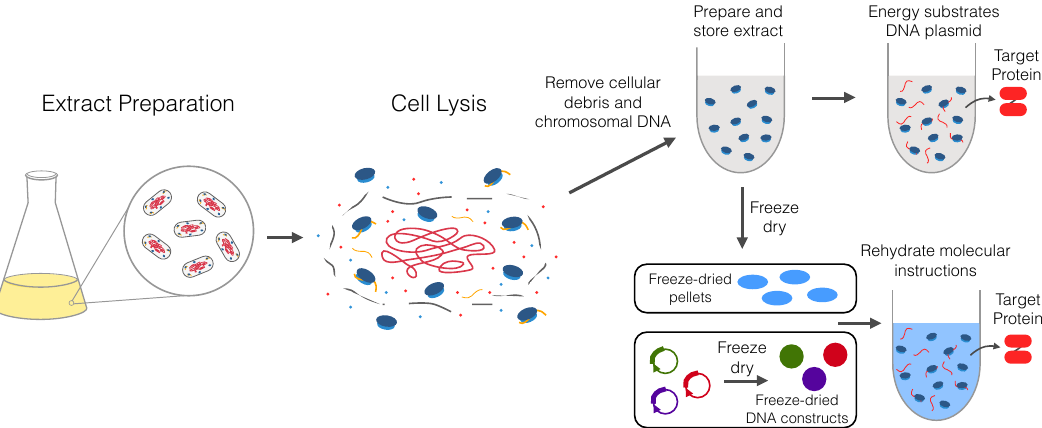
Figure 2. Schematic of cell-free protein synthesis. Cell extract is prepared by cell lysis, and cellular debris and chromosome DNA is removed. An energy source along with the necessary amino acids, nucleotides, and cofactor are added to the cell-free reaction. Template DNA of the target protein is added. The target protein is then easily purified from the cell-free system. Alternatively, cell-free extract can be freeze dried into pellets and paired with lyophilized DNA. Through the simple addition of water, proteins can be manufactured on site and on demand. Figure adapted from